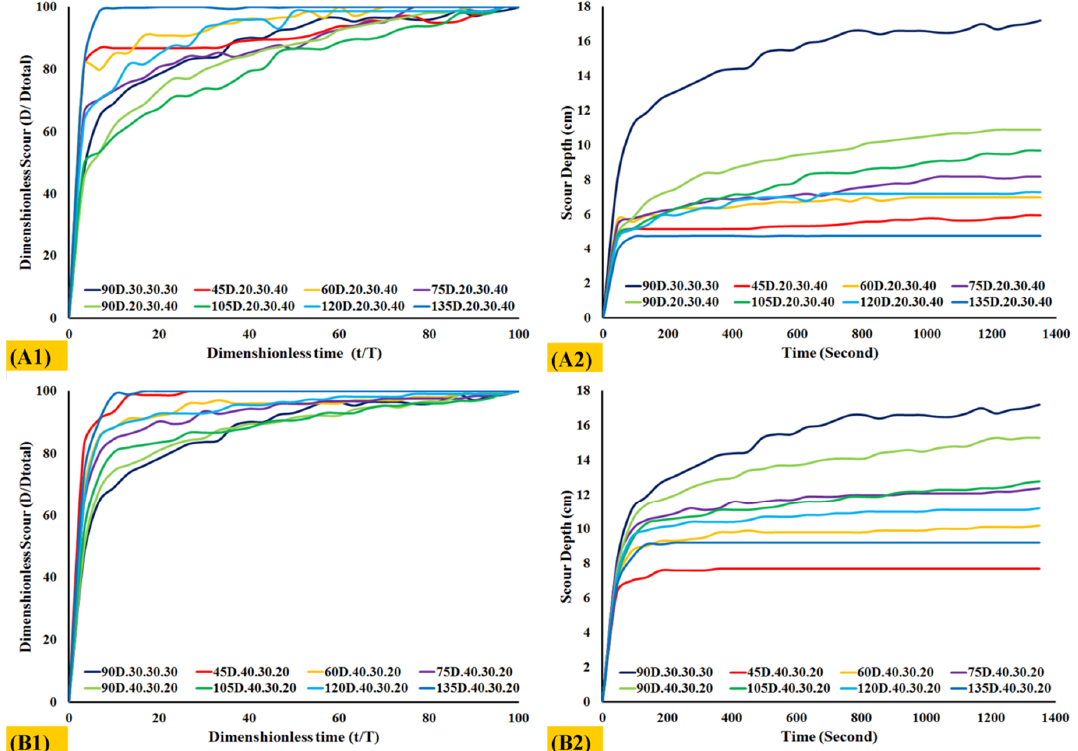
Figure 8. ( A1 ) Dimensionless scour versus time in the simulation 2/8. ( A2 ) Scour depth versus time in the simulation 2/8. ( B1 ) Dimensionless scour versus time in the simulation 1/9. ( B2 ) Scour depth versus time in the simulation 1/9. D is maximum scour depth at each time and D total is maximum scour depth at the end of the simulation time. Table 6. Scouring results from the simulation 1/15. Simulation